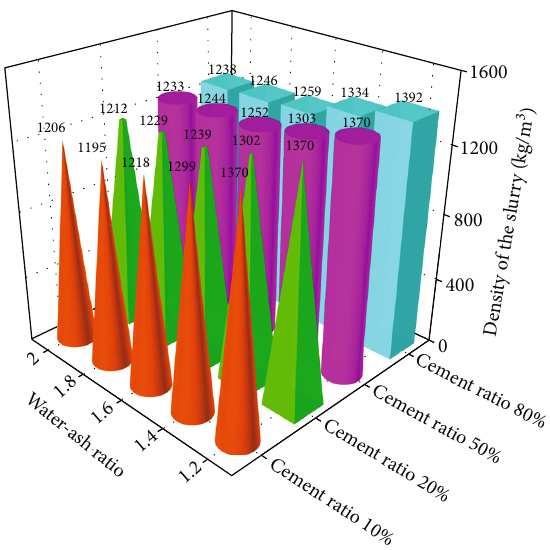
Figure 3: Density of modi fi ed fl y ash slurry with di ff erent water- ash ratios and cement